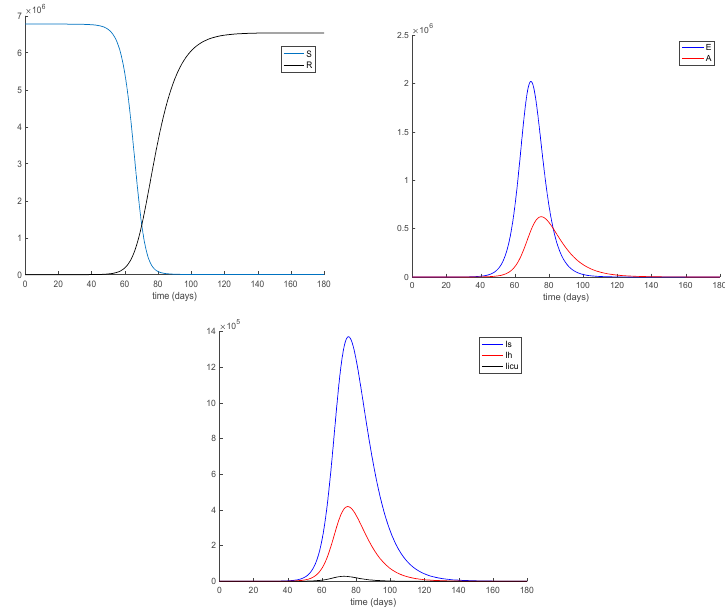
Figure 1. Evolution of all the populations of the model in the absence of external control actions.